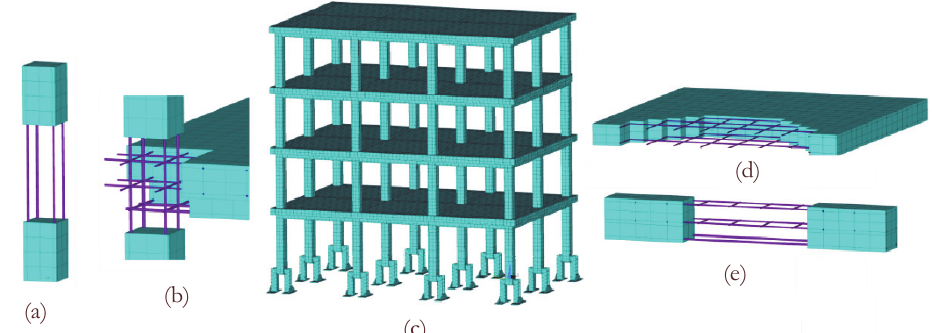
Figure 2: The finite element model of RC structure: (a) – a fragment of the column; (b) – reinforcement of the joint of the column, slab and cross beams; (c) – assembled structure; (d) – slab fragment; (e) – beam